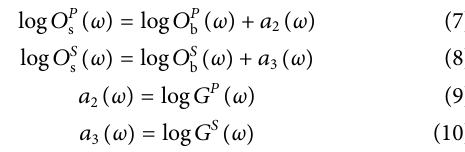
Frontiers in Earth Science |